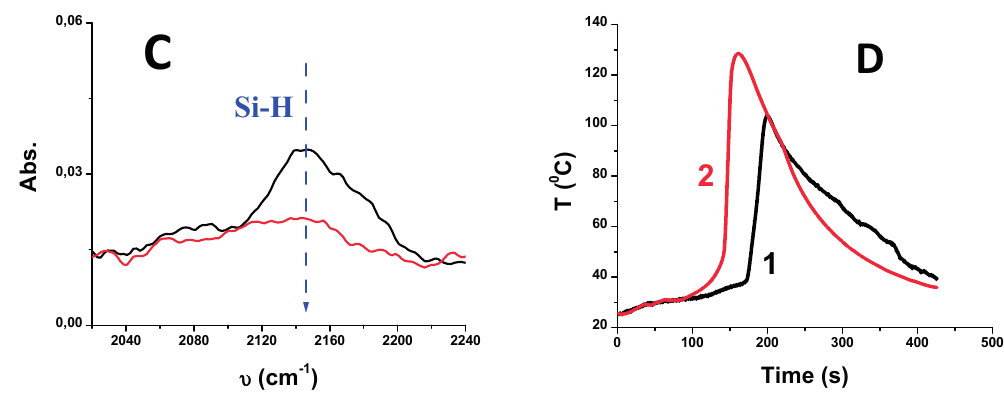
Figure 5. ( A ) Role of the organosilane in the thermal interpenetrated polymer networks (IPNs) of TMPTA/EPOX blend (50%/50%) under air in the presence of DPSi/NVK/AgSbF 6 (2%/2%/1% w/w ). ( B ) IR spectra recorded during the thermal IPN polymerization of the TMPTA/EPOX blend (50%/50%) of sample containing 1% (wt) of AgSbF 6 , 2% (wt) of DPSi and 2% (wt) of NVK ( 1 ) before and ( 2 ) after polymerization. ( C ) IR band of the decreasing of the DPSi recorded during the polymerization. ( D ) Role of the concentration of organosilane in the thermal interpenetrated polymer networks (IPNs) of TMPTA/EPOX blend (50%/50%) under air in the presence of NVK/AgSbF 6 (2%/1% w/w ): ( 1 ) with 1% (wt) DPSi and ( 2 ) 2% (wt) DPSi.